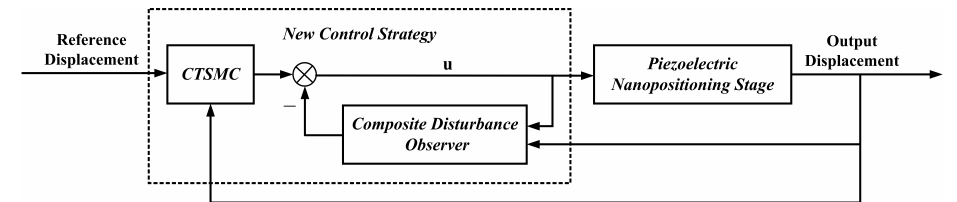
Figure 1. Control block diagram of piezoelectric nanopositioning stage